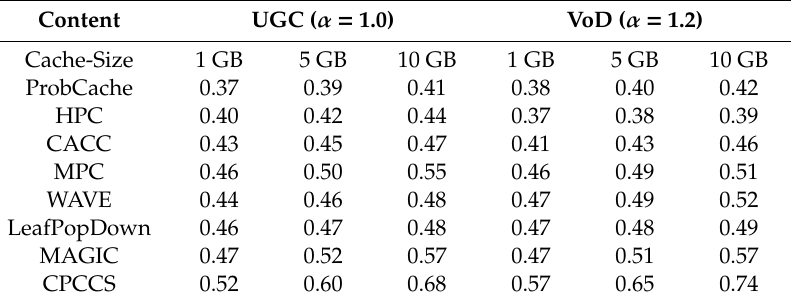
Table 2. Numerical values on content diversity.